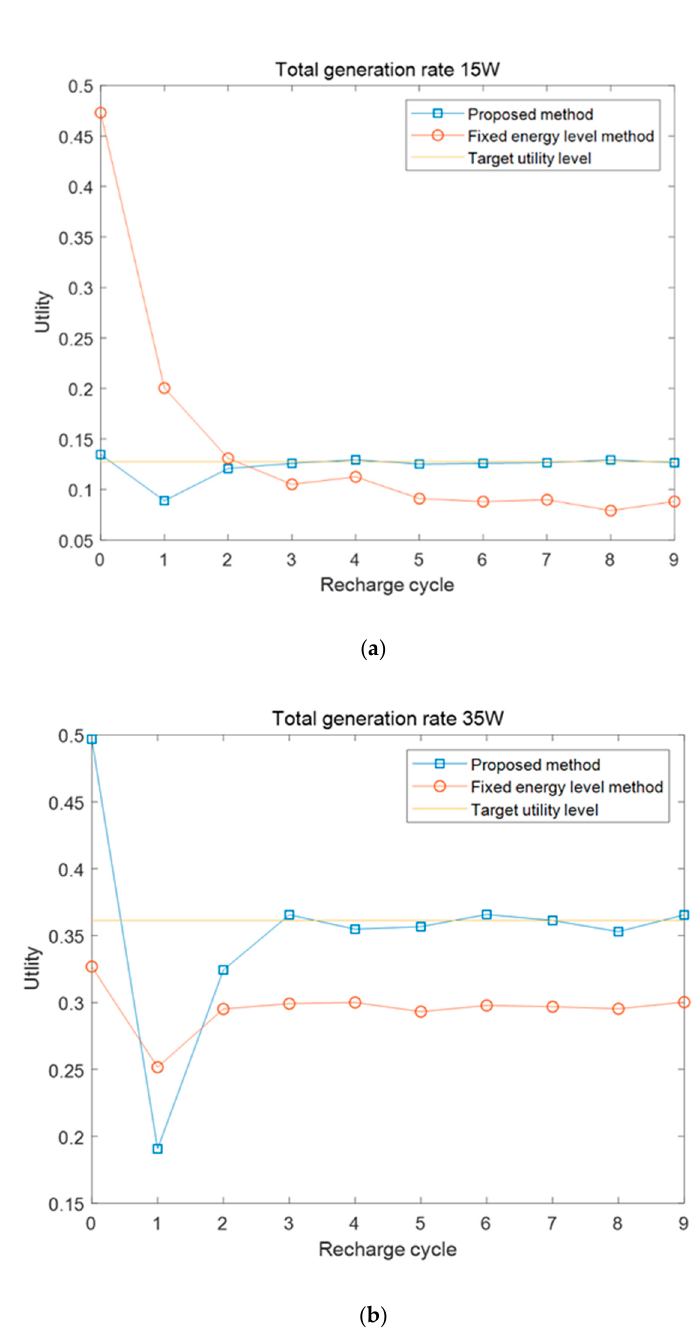
Figure 6. Mobile robot utilization rate. ( a ) Total generation rate 15 W; ( b ) Total generation rate 35 W.